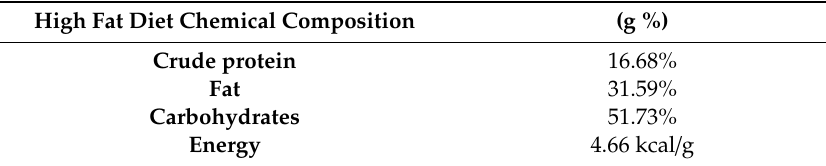
Table 2. Chemical composition of high fat